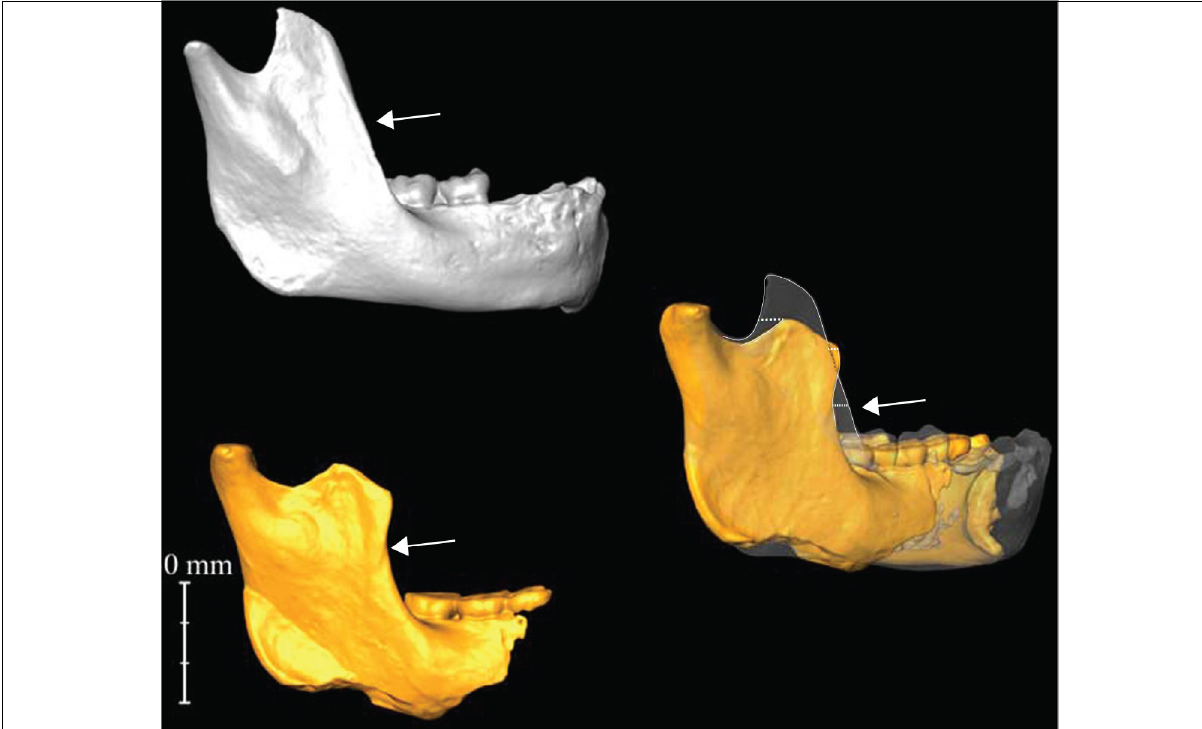
Figure 5: A portion of Berger et al.’s figure S2 2 showing MH1 (upper) and MH2 (lower). Berger et al. 2 have superimposed MH1 on MH2 (right), resulting in a vivid illustration of the morphologies that we claim distinguish between Australopithecus and Homo . For best viewing, enlarge the image. Note the three dotted white lines that we added to the right-hand image. These three lines indicate the differing morphologies of the upper part of the ramus. The white arrows point to the preangular notch or its Research Article 4 Volume 117| Number 5/6 https://doi.org/10.17159/sajs.2021/8747 May/June 2021